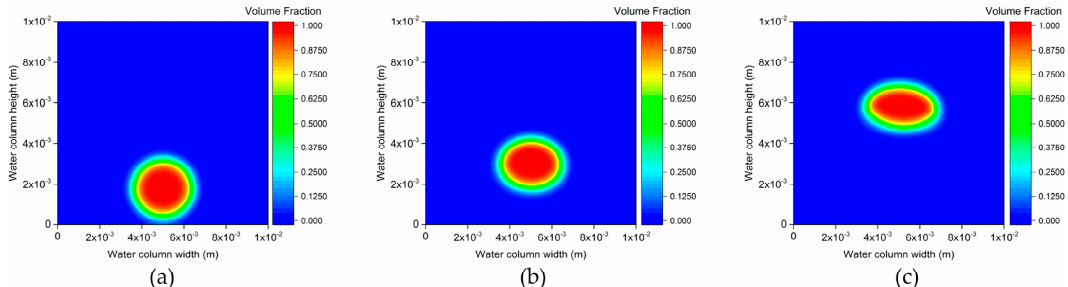
Figure 6. Contour plots of the 2.77 × 10 − 3 m air bubble rising through the water column at: ( a ) 0; ( b ) 0.02; and ( c ) 0.04 s. Blue color represents water and red color represents the air bubble.